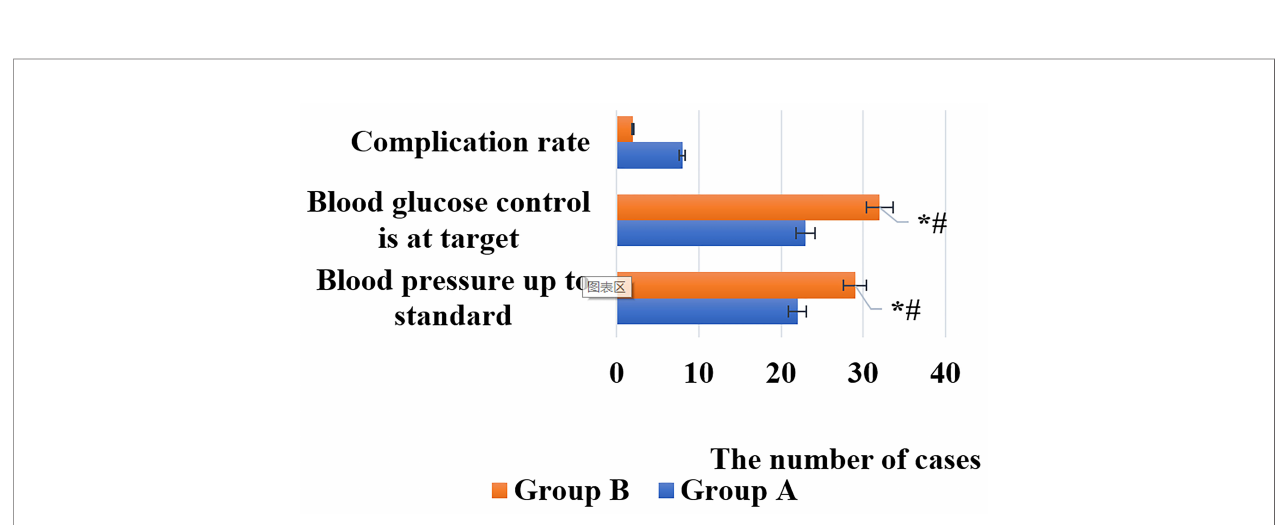
FIGURE 4 | Comparison of rehabilitation effects between the two groups of patients [*# indicated that compared with group A, the difference was statistically signi fi cant ( P <